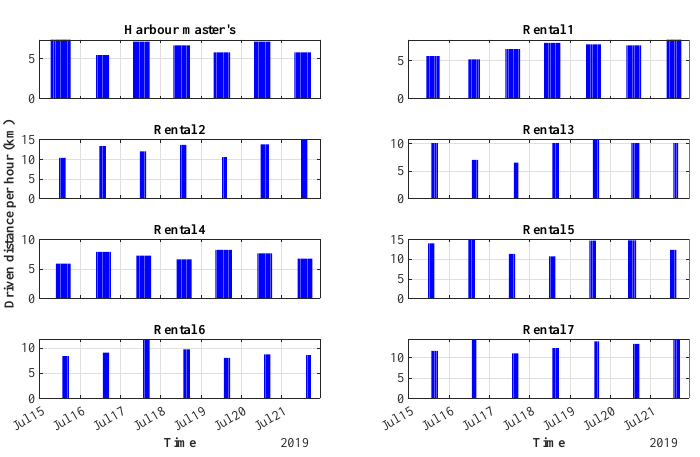
Figure 12. Generated electric car usage pattern for the eight cars.